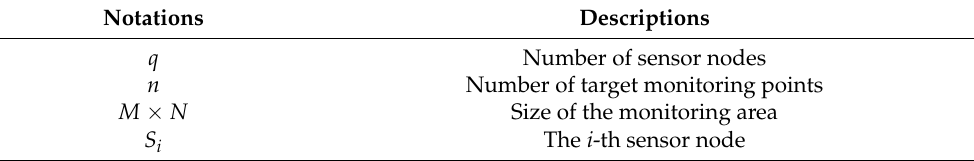
Table 1. Notation